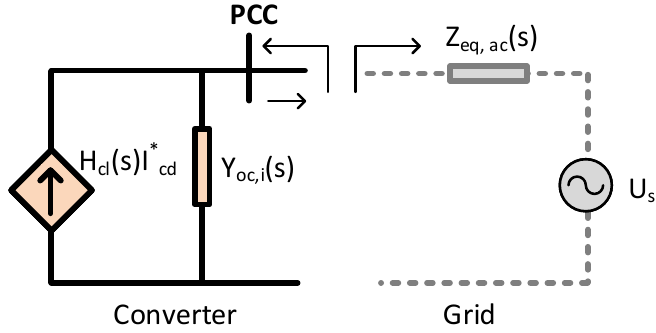
Figure 5. Equivalent circuit representation of current controller relative to the grid.